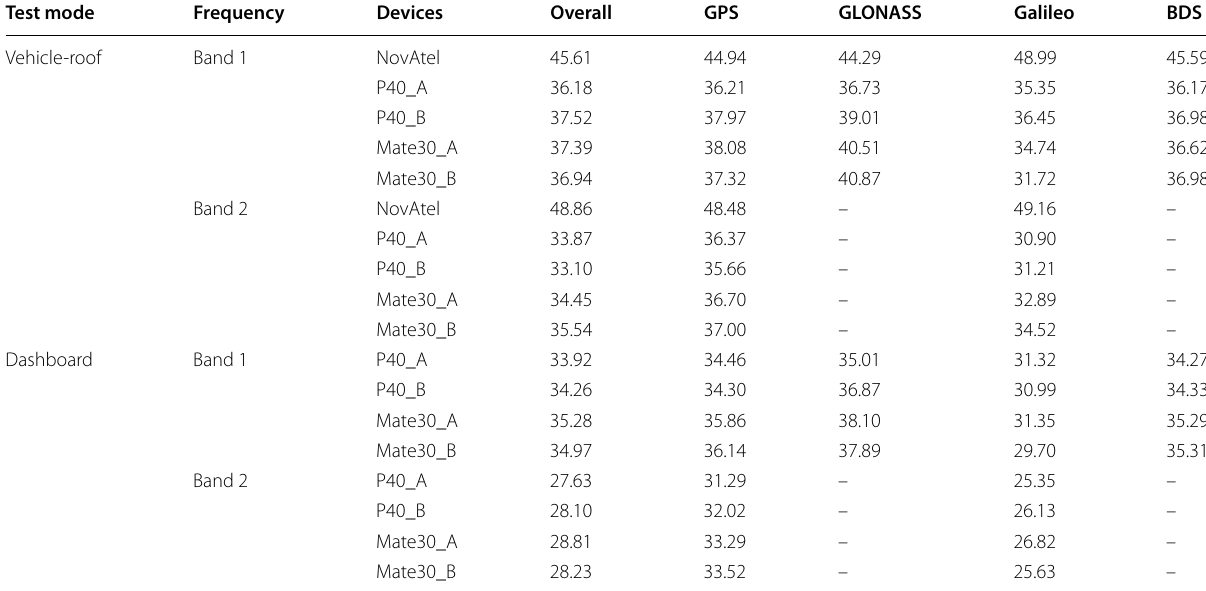
Table 1 Statistical results of average GNSS signal C/N mode with smartphones and the geodetic NovAtel receiver (unit: dB